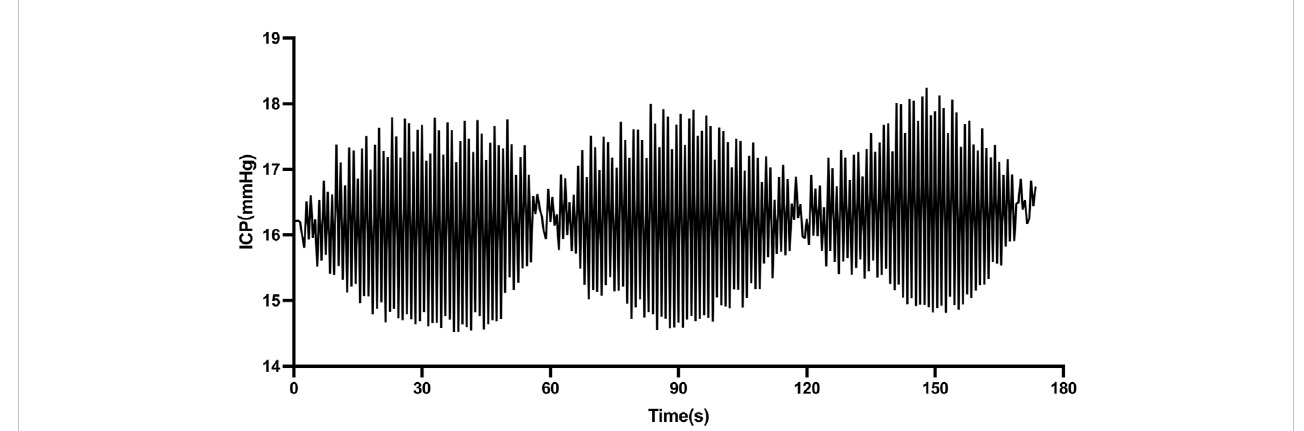
FIGURE 1 Morphology of spindle waves in patients with traumatic brain injury (TBI) (1 mmHg = 0.133